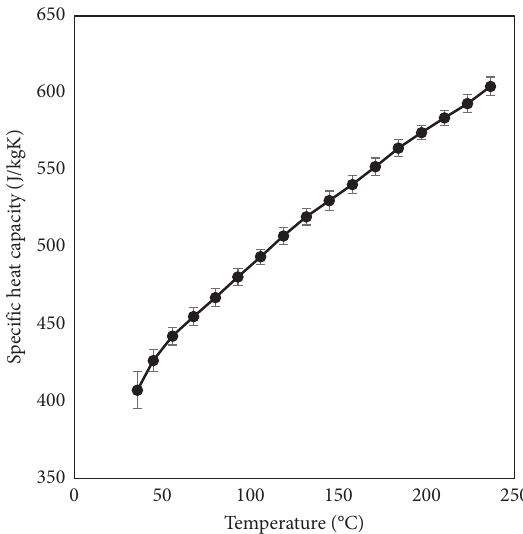
Figure 5: Specific heat capacity of CuCD